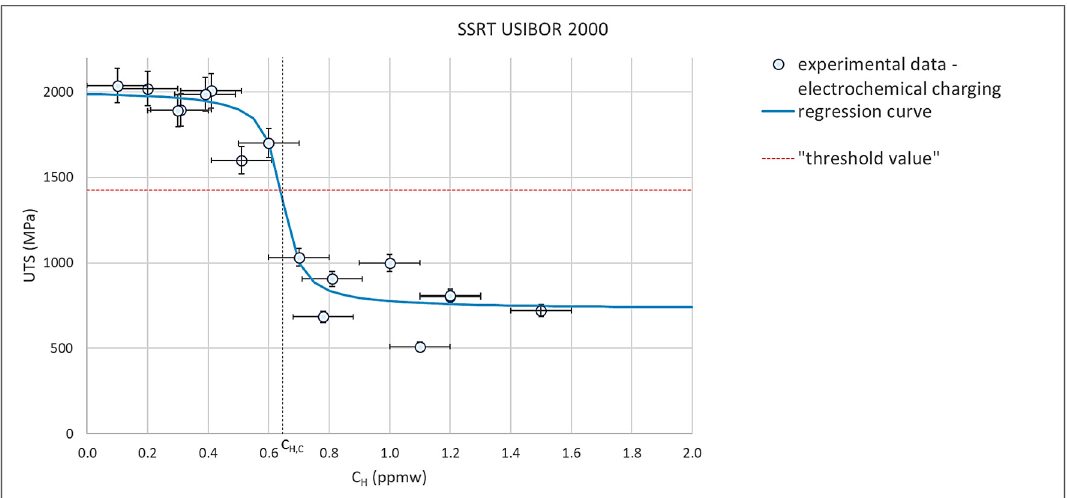
Figure 7. SSRT for USIBOR 2000 ® .